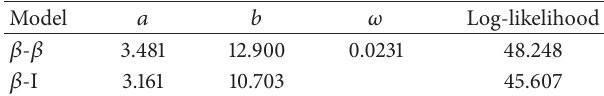
Table 3: The maximum likelihood estimates of the model parame- ters under the 𝛽 - 𝛽 model and the 𝛽 -I model.